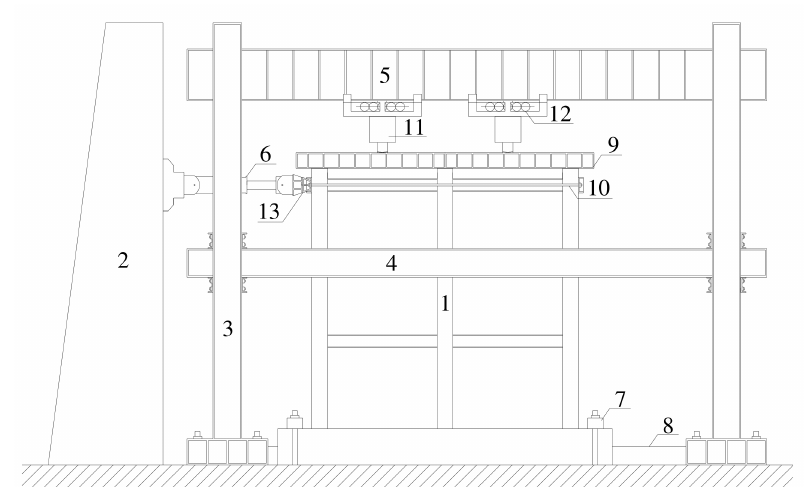
Figure 2. Schematic diagram of test loading device. 1. Steel reinforced recycled concrete column- steel beam composite frame specimen; 2. Reaction wall; 3. Reaction framework; 4. Lateral bracing beam; 5. Reaction girder; 6. MTS hydraulic servo actuator; 7. Pressure beam; 8. Horizontal shear embedded support; 9. Distribution beam; 10. Force transfer chain rods; 11. Oil jack; 12. Sliding support; 13. Loading end.